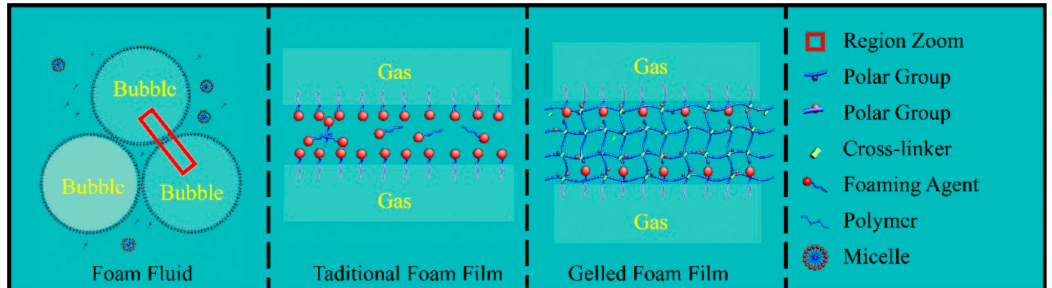
Figure 9. Stabilization mechanism of the gelled